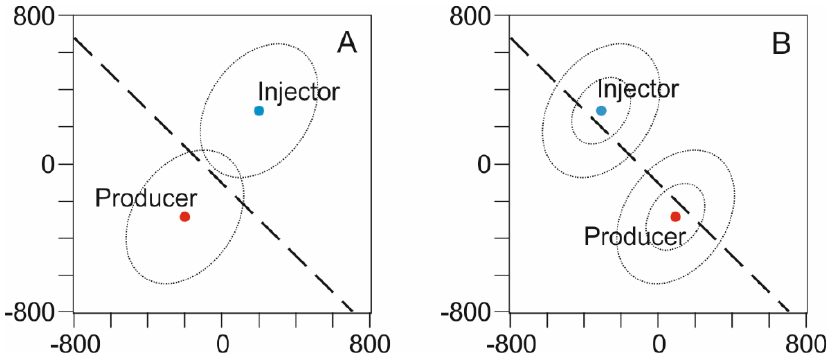
Figure 5. Top view slice cutting the center of the model and illustrating the different wells configu- ration studied. In ( A ) the wells are placed perpendicular to the fault trace and parallel to the direction of the maximum horizontal principal stress. In ( B ) the wells are placed parallel to the fault trace and minimum horizontal principal stress. Dots—vertical wells, dashed line—Lac Pingiajjulik fault trace, ellipsoids—stimulation volume per well tried (larger ellipsoid, V = 0.4 km 3 ; smaller ellipsoid, V = 0.2 km 3 ; the sum of the stimulated volumes in each well were defined to correspond to 20% and 10%, respectively, of the total model volume).